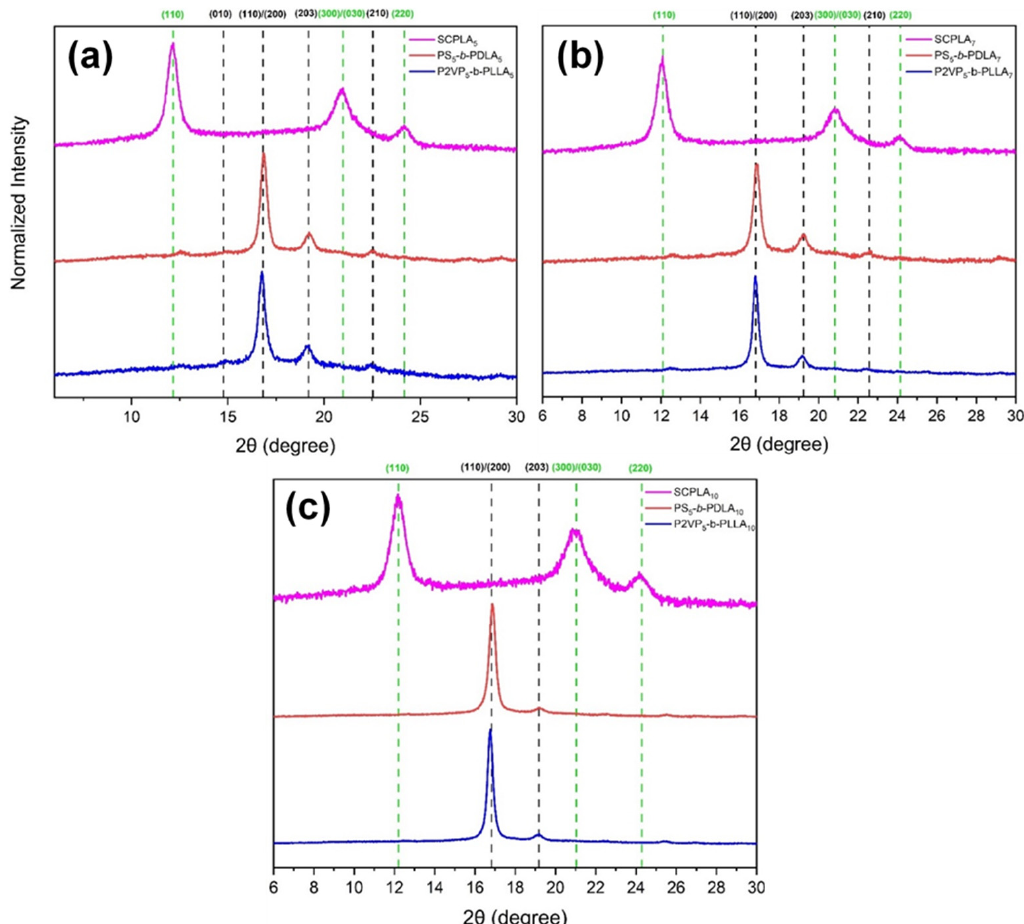
Figure 5. XRD patterns of PS- b -PDLAs, P2VP- b -PLLAs, and the corresponding SCPLAs with PLA segments with molecular weight of ( a ) 5 kg mol − 1 , ( b ) 7 kg mol − 1 , and ( c ) 11 kg mol − 1 (samples were cast on top of the glass substrate).